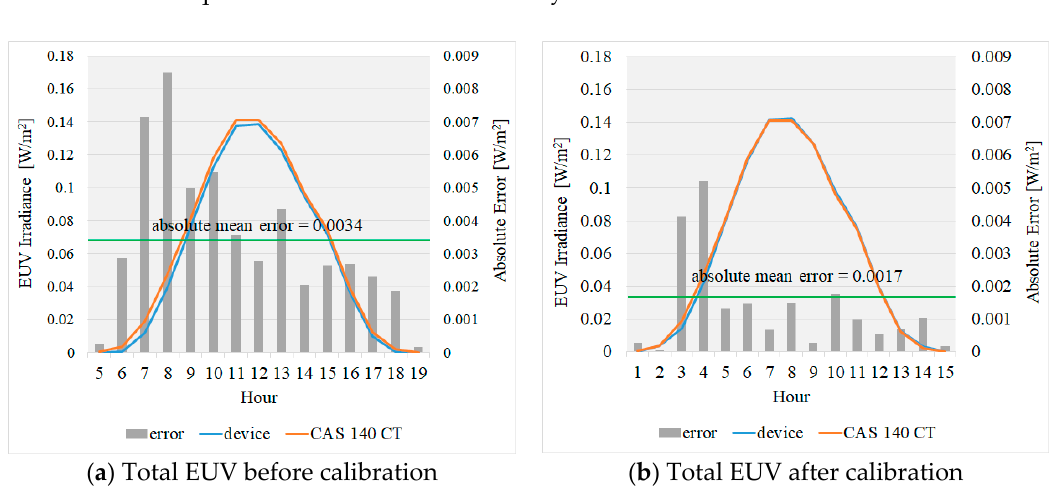
Figure 8. EUV graphs before and after the application of the compensation equation.